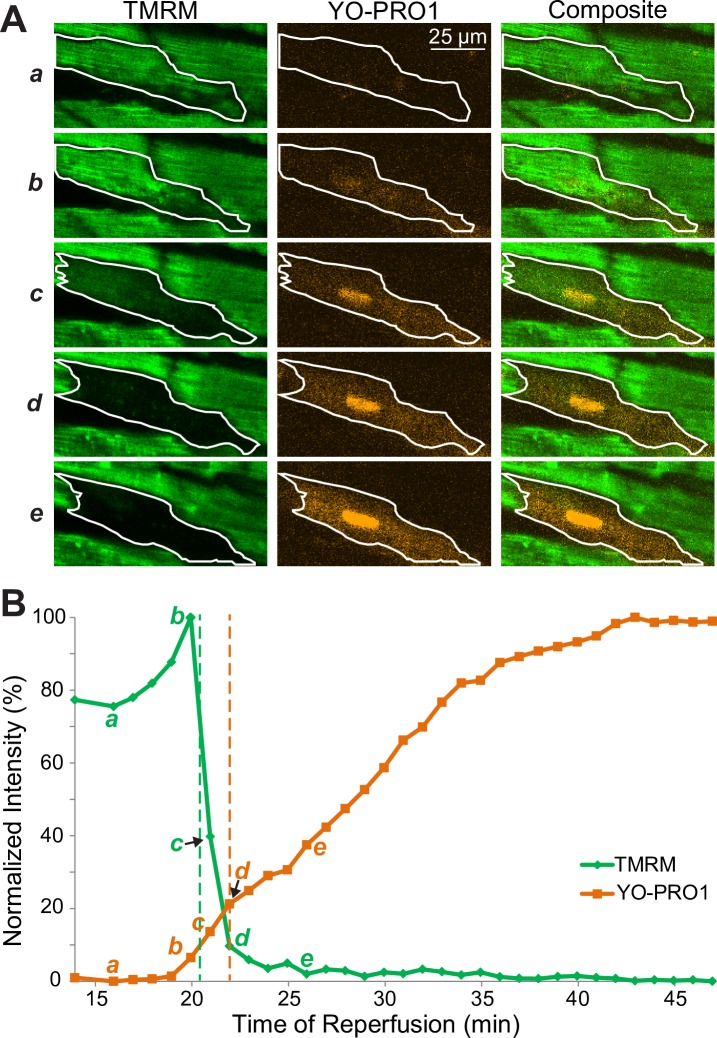
Detailed spatiotemporal analysis of FTMRM loss and FYO-PRO1 gain during reperfusion in a representative myocyte from a control heart.A, each row shows FTMRM (green), FYO-PRO1 (orange) and the merged image of the cell undergoing the critical transition (outlined with white) for different time points (a to e) indicated in B. B, the cell-averaged FTMRM (green) and FYO-PRO1 (orange) as the function of time shown as 0–100% of the dynamic range of each signal. The vertical green and orange dashed lines indicate TMPT and TSP, respectively. Note the spatiotemporal overlap between the processes of FTMRM loss (indicator of MPT) and FYO-PRO1 gain (indicator of SP), such that at time point b there is a clear uptake of YO-PRO1 while the majority of the cell interior still shows polarized mitochondria.